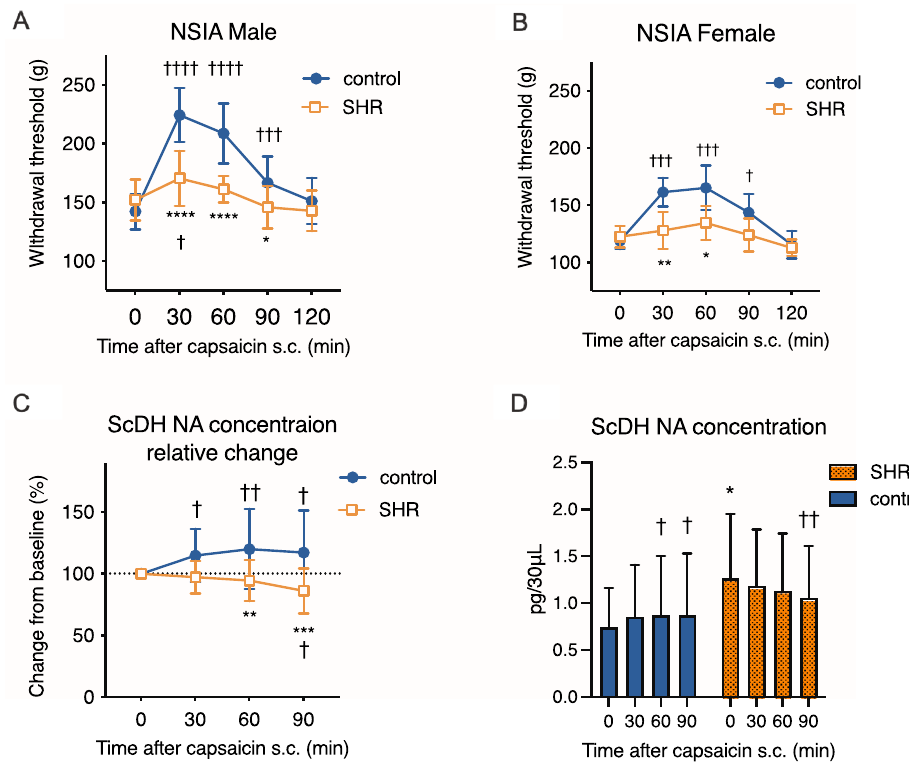
Figure 1. Noxious stimuli-induced analgesia (NSIA) in SHR is attenuated. Left forepaw injection of capsaicin raised the withdrawal threshold of the right hind paw of control from 30 to 90 min after injection. SHR, however, respond to capsaicin only at 30 min in male ( A ). Female SHR does not respond to capsaicin ( B ). Relative change in the noradrenaline concentration in the spinal dorsal horn after capsaicin injection was measured by microdialysis ( C ). Left forepaw injection of capsaicin increased the noradrenaline concentration in the spinal dorsal horn at 30, 60, and 90 min after injection. In SHR, however, the spinal dorsal horn NA concentration decreased from 60 and 90 min. The baseline spinal noradrenaline concentration from the microdialysate is higher in SHR ( D ). Mean ± SD, ††††; p < 0.0001 versus time 0, †††; p < 0.001 versus time 0, ††; p < 0.01 versus time 0, †; p < 0.05 versus time 0, ****; p < 0.0001 versus control, ***; p < 0.001 versus control, **; p < 0.01 versus control, *; p < 0.05 versus control, n = 16 male, 8 females for each strain (WKY-male:16, WKY- female:8, SHR-male:16, SHR-female:8), n = 20, 17 (C, D, male only). SHR: spontaneously hypertensive rats (ADHD model), control: Wister